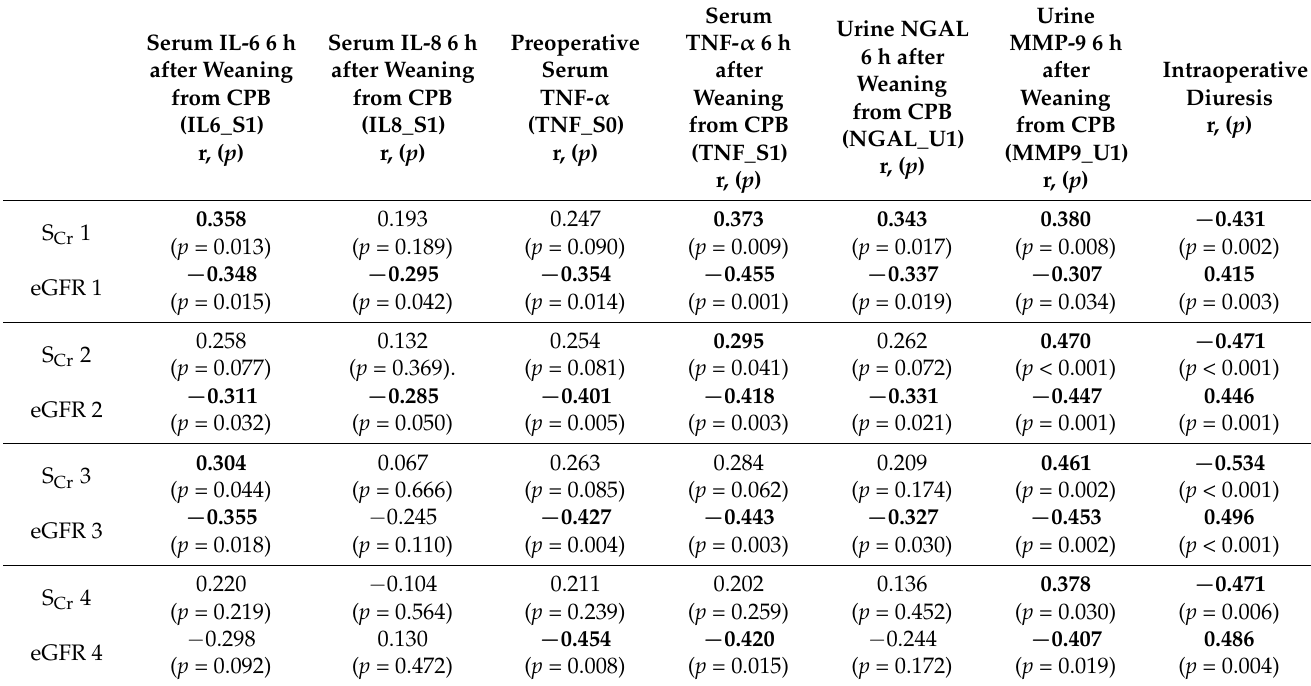
Table 5. Relationship between selected parameters and early postoperative kidney function. Spearman rank correlation coefficients are presented together with statistical significance (“r” for p -value < 0.05 are put in bold).